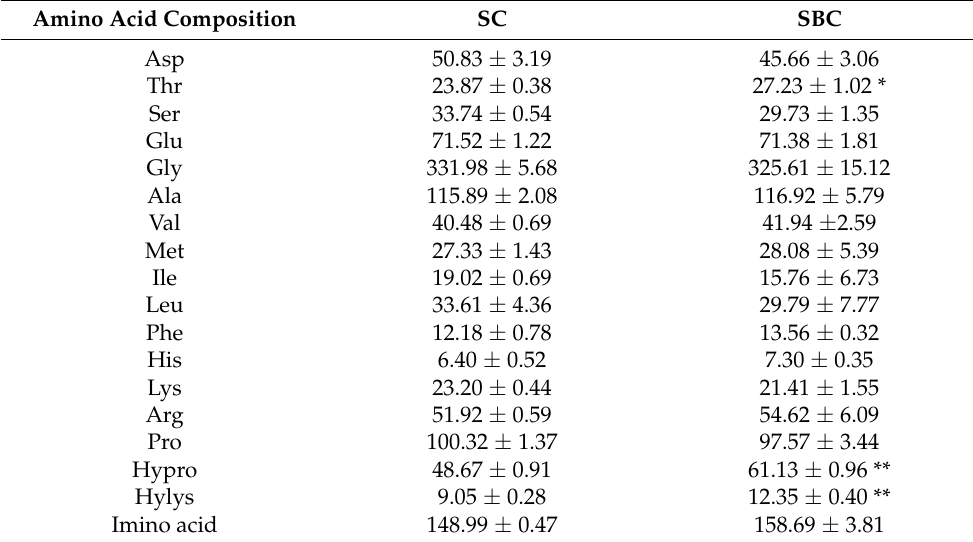
Table 1. Amino acid composition of C. idella skin collagen (SC) and swim bladder collagen (SBC) expressed as residues/1000 total amino acid residues.